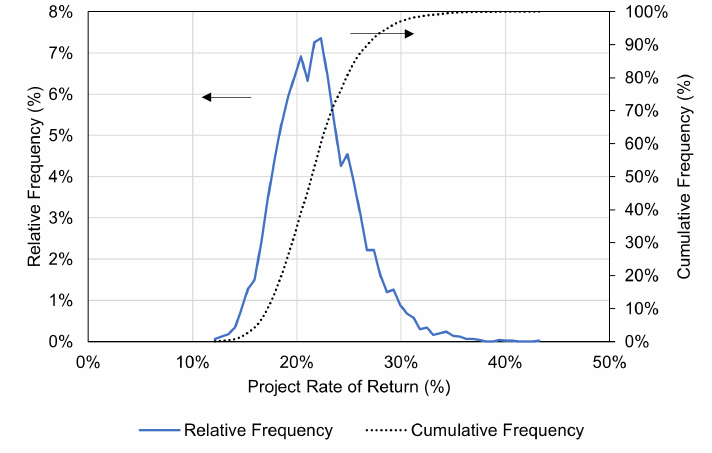
Figure 8. Results from Monte Carlo simulation showing rate of return. Current pricing, magnet element-only